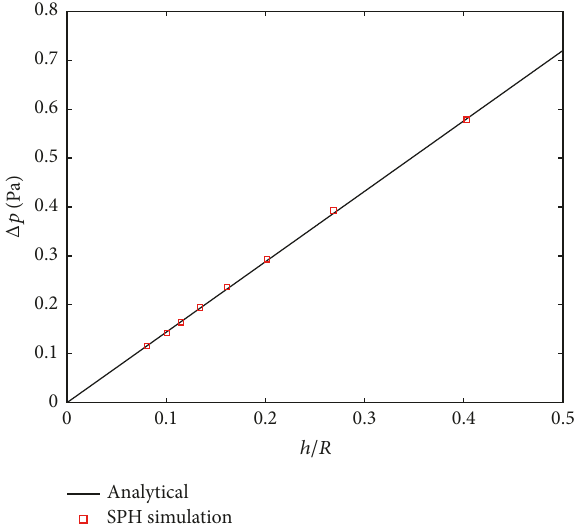
Figure 5: Laplace’s law for spherical bubbles. Pressure step versus ℎ/𝑅 .